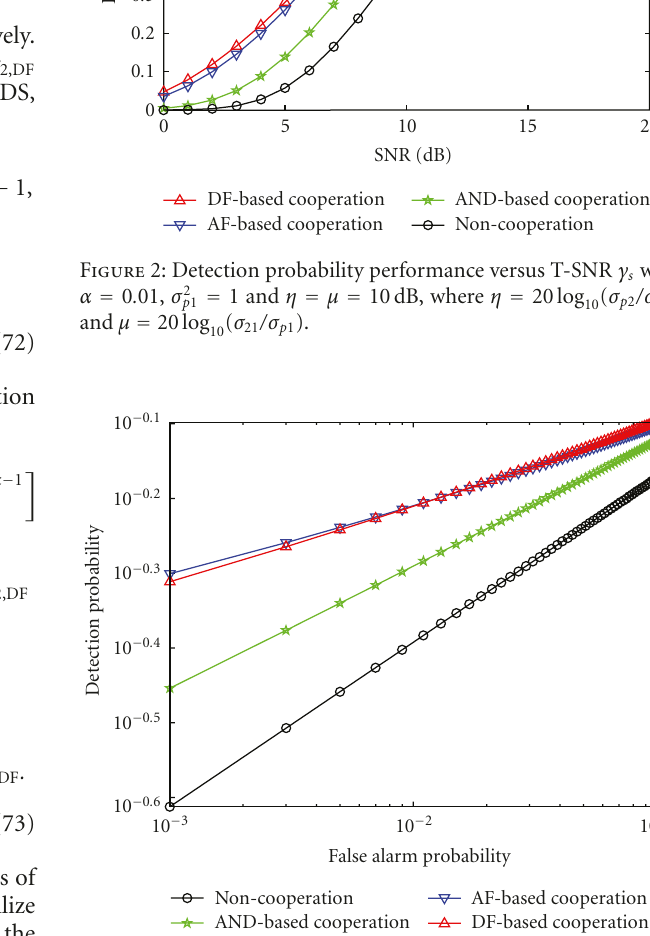
Figure 3: Detection probability versus false alarm probability with γ s = 10dB, σ 2 p 1 = 1 and η = μ = 10dB, where η = 20log ( σ 21 /σ p 1 and μ = 20log 10